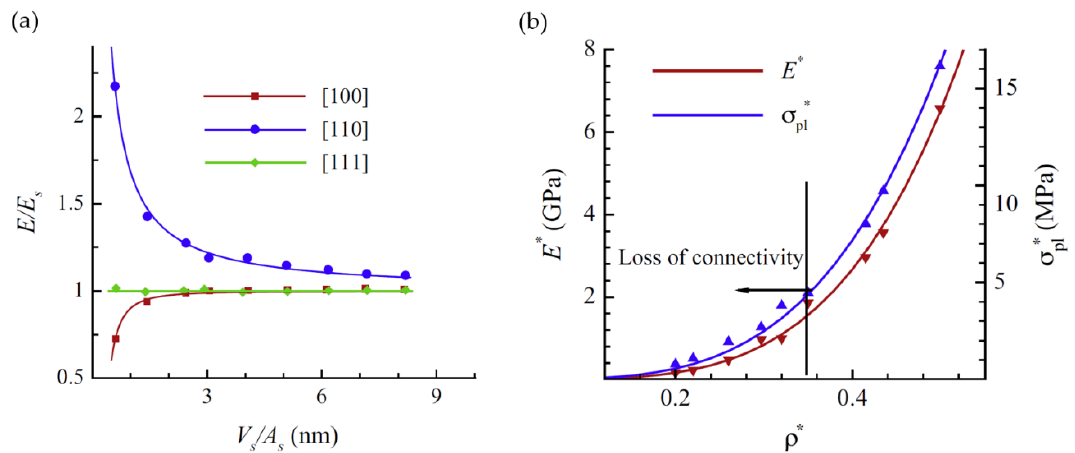
Figure 15. ( a ) Predicted Young’s modulus of nanowires normalized by the bulk modulus for different crystal orientations along the wire axis of width 𝑤 = 4𝑉 𝑠 /𝐴 𝑠 ; ( b ) the scaling behavior of effective mechanical properties with loss of connectivity for solid fractions below around 35% that is caused by voxel erosion. All variables with (·) ∗ denote size-independent values for that specific orientation and density. Reprinted from [15] with permission from Elsevier.